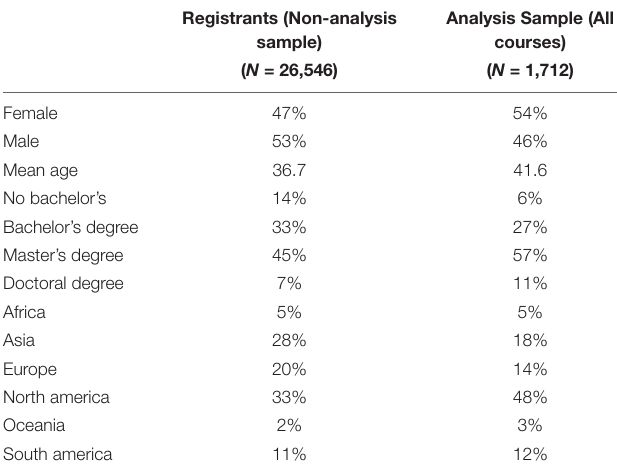
TABLE 1 | Demographic composition by course (all registrants and analytic